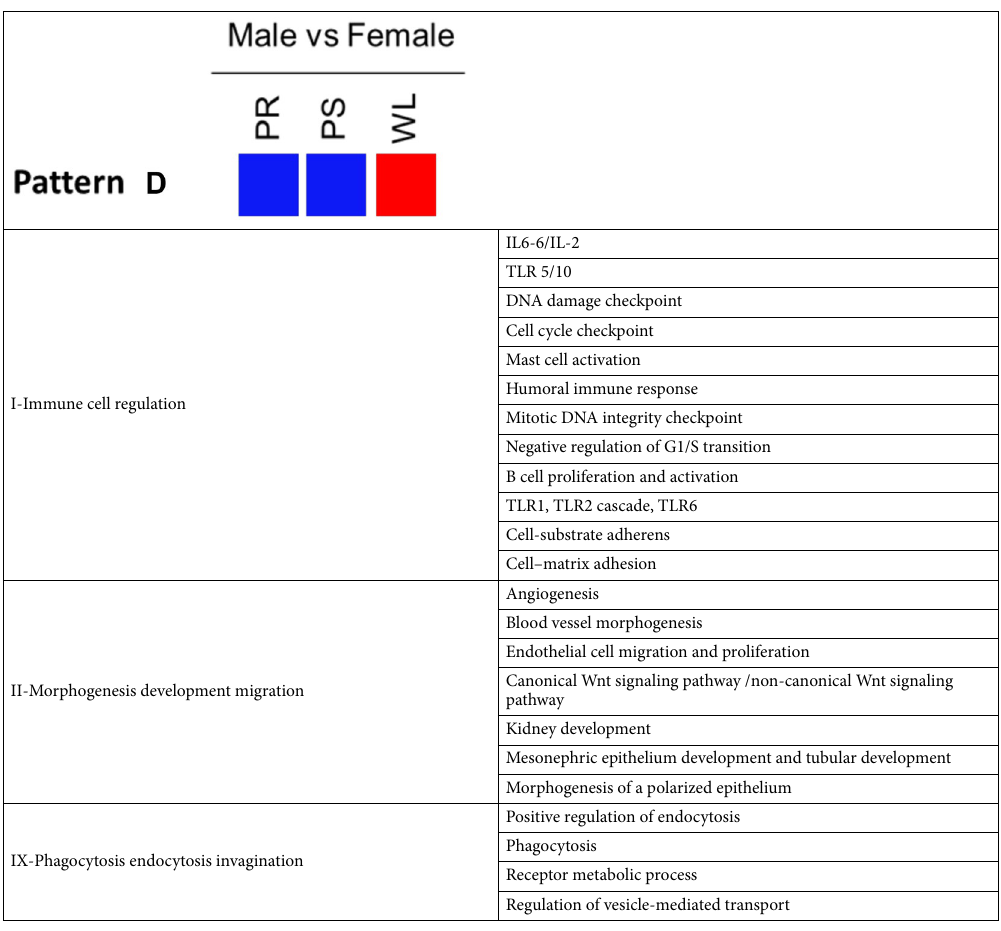
Table 9. Summary of clusters and gene sets included in the pattern B for the renal IRI sex